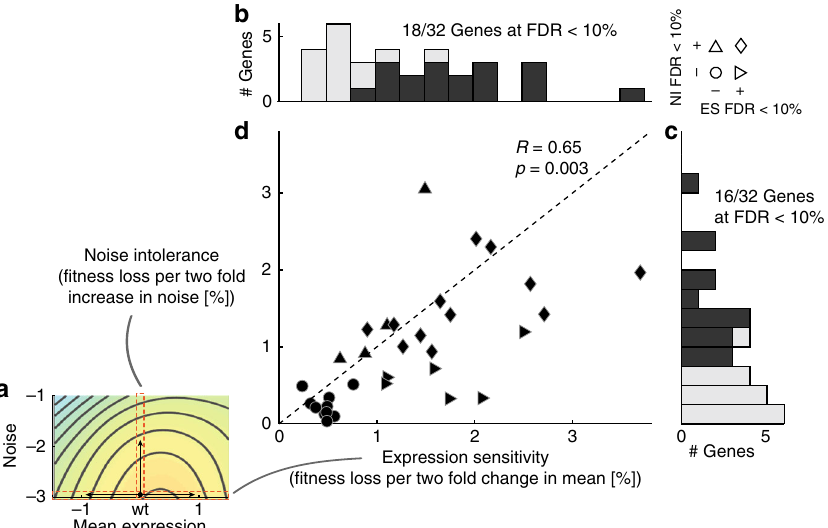
Fig. 4 High noise is nearly as detrimental as non-optimal mean expression. a A gene ’ s expression sensitivity is the loss of fi tness upon two-fold changes in mean expression at low expression noise (indicated by horizontal red bar). Its noise intolerance is the loss of fi tness upon a two-fold increase noise levels at wild-type mean expression (indicated by vertical red bar). b Distribution of expression-sensitivity across 32 genes, of which 18 are signi fi cantly sensitive at false discovery rate < 10% (dark colour). c Distribution of noise intolerant across 32 genes of which 16 are signi fi cantly intolerant at false discovery rate < 10% (dark colour). d Relationship between expression sensitivity and noise intolerance across all genes. Pearson correlation coef fi cient and p , the fraction of 10 4 sets of randomized landscapes that have Pearson correlation coef fi cients greater than the one found on the real landscapes, are indicated. Shapes indicate false discovery rate combinations of genes with respect to expression sensitivity and noise intolerance, as shown in legend in upper right corner of the plot. Note that results for RAP1 are not shown and are discussed in the Supplementary Note 1. Source data are provided as a Source Data fi